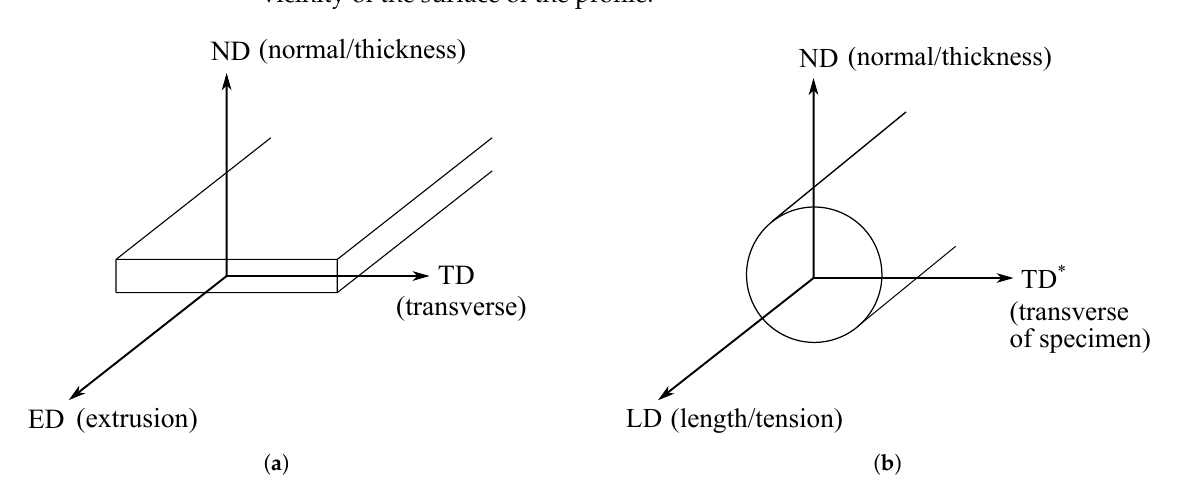
Figure 1. Coordinate system of ( a ) the extruded profiles, and ( b ) the axisymmetric tensile test specimens. The asterisk (*) differentiates the transverse direction of the profile (TD) from the transverse direction of the specimen